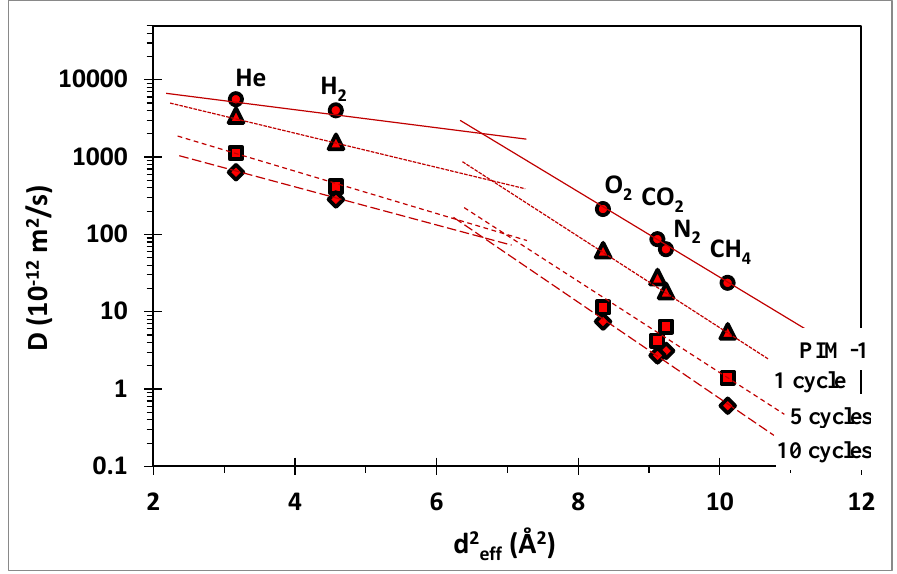
Figure 9. Robeson’s plots for four gas pairs of industrial interest. The dashed line and the solid line represents the Robeson 1991 upper bound [1] and the 2008 upper bound [2], respectively. Red series: neat PIM-1 ( ) and ZIF-8/PIM-1 after 1( ), 5( ) and 10( ) growth cycles; Green series: AMD-PIM1